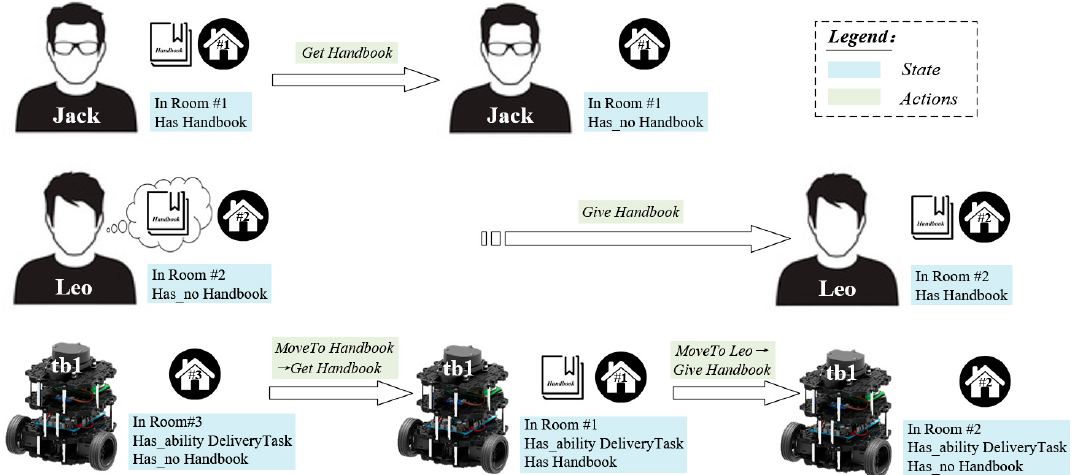
Figure 9. The environment state changes in a simple indoor service DeliveryHandbooktoLeo: the TurtleBot3 need to get the handbook from Jack and then give the handbook to Leo.